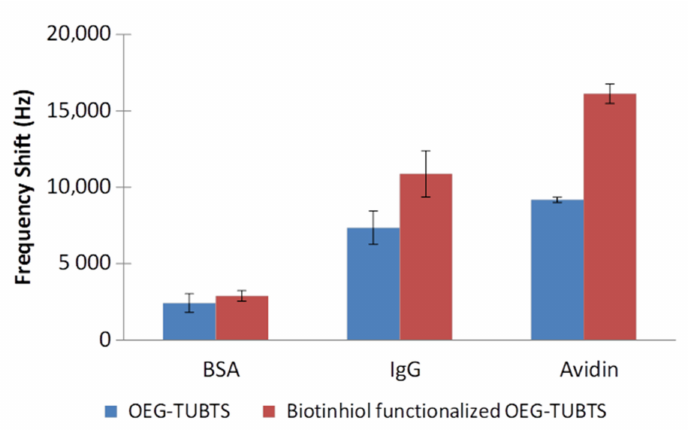
Figure 6. EMPAS measured with OEG–TUBTS and biotinylated OEG–TUBTS SAMs, using